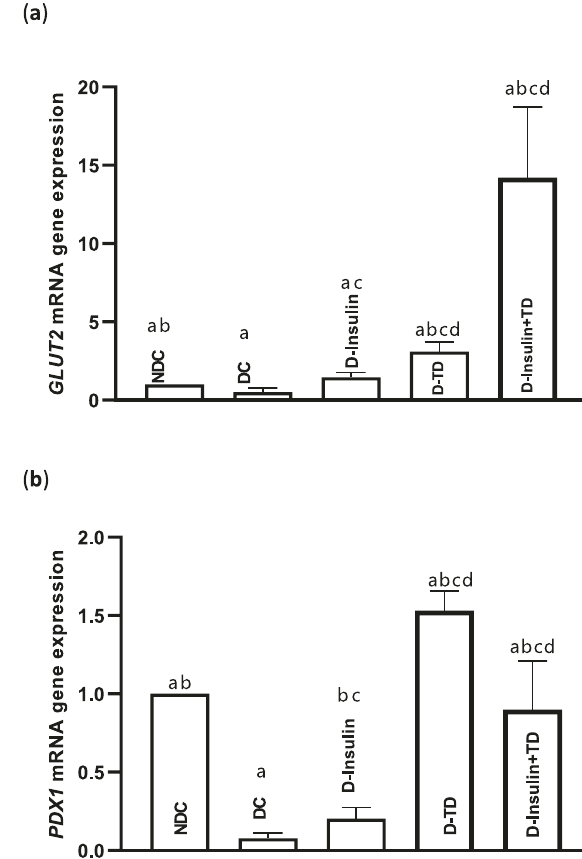
Fig. 6 Effect of TD on mRNA expression of pancreatic genes. Comparison of mRNA expression of Glut2 ( a ), mRNA expression of Pdx1 ( b ) in the non-diabetic control (NDC), diabetic control (DC), D-insulin, D-TD, and D-insulin + TD groups. DC group received 60 mg/kg STZ. D-insulin group diabetic animals treated with 2.5 U/ kg insulin twice per day (1/3 morning and 2/3 in the evening), D-TD group diabetic animals treated with daily IP injection of 40 mg/kg thiamine disul fi de, D-insulin + TD group diabetic animals treated with TD and insulin (2.5 U/kg insulin + 40 mg/kg TD once per day). Data are expressed as mean ± S.E.M ( N = 7). a Signi fi cant difference in mRNA expression of Pdx1 between the DC group and other groups (DC vs NDC ( p < 0.05), DC vs D-insulin ( p < 0.01), DC vs D- insulin + TD ( p < 0.0001), DC vs D-TD ( p < 0.001)) and signi fi cant difference in mRNA expression of Glut2 (DC vs NDC ( p < 0.001), DC vs D-TD ( p < 0.0001)). b Signi fi cant difference in mRNA expression of Pdx1 between the NDC group and other groups, (NDC vs D-insulin + TD ( p < 0.001), NDC vs D-TD ( p < 0.01)) and (NDC vs D-insulin and signi fi cant difference in mRNA expression of Glut2 (D-TD ( p < 0.001), and NDC vs D-insulin + TD ( p < 0.05). c Signi fi cant difference between the D-insulin group and the other two treatments (D-TD and D-insulin + TD) groups (D-insulin vs D-TD ( p < 0.01), D-insulin vs D-insulin + TD ( p < 0.0001)) for mRNA expression of Pdx1 and ( p < 0.01) for mRNA expression of Glut2 . d Signi fi cant difference between the D-TD and D-insulin + TD groups, ( p < 0.05) for mRNA expression of Pdx1 and ( p < 0.001) for mRNA expression of Glut2